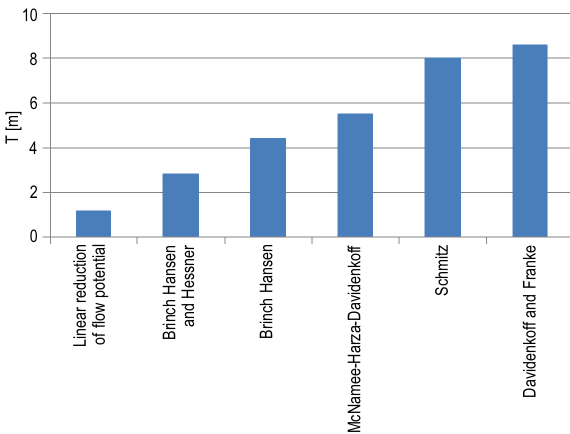
Fig. 1. Embedded length T obtained by several approximate solutions for an excavation with a width of B = 10 m and a difference of water level of H = 10